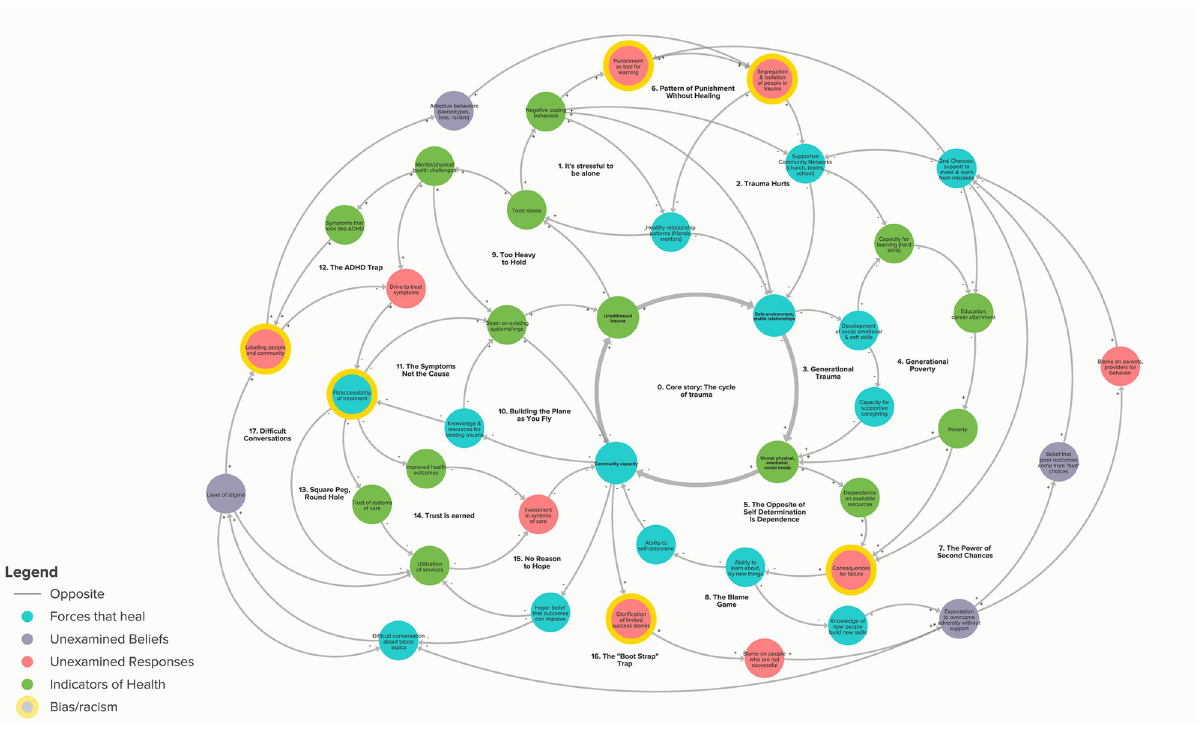
Fig 3. The final